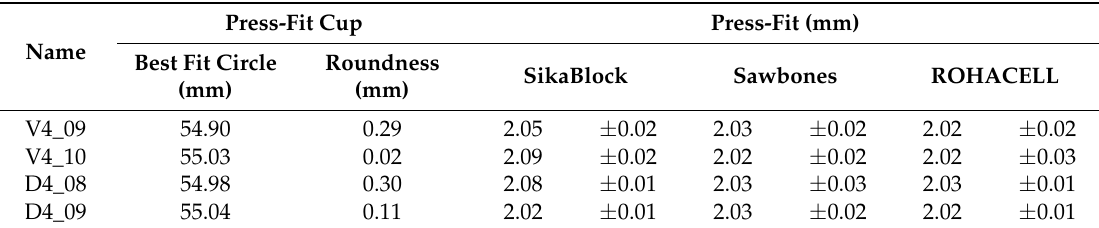
Table 3. List of relevant dimensions for the press-fit cups and press-fits (bone bearing–press-fit cup = press-fit). The arithmetic mean results from the number of samples n = 5.